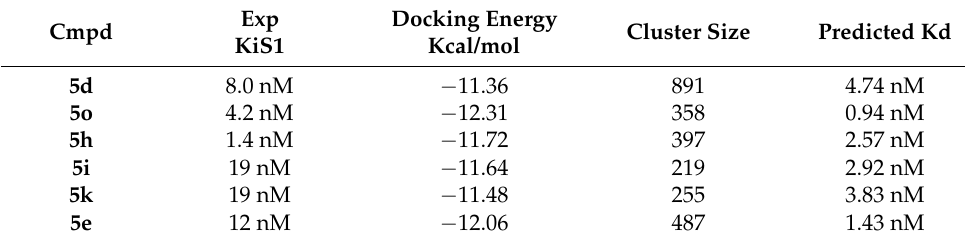
Table 3. Comparison between experimental and docking predicted binding affinities.